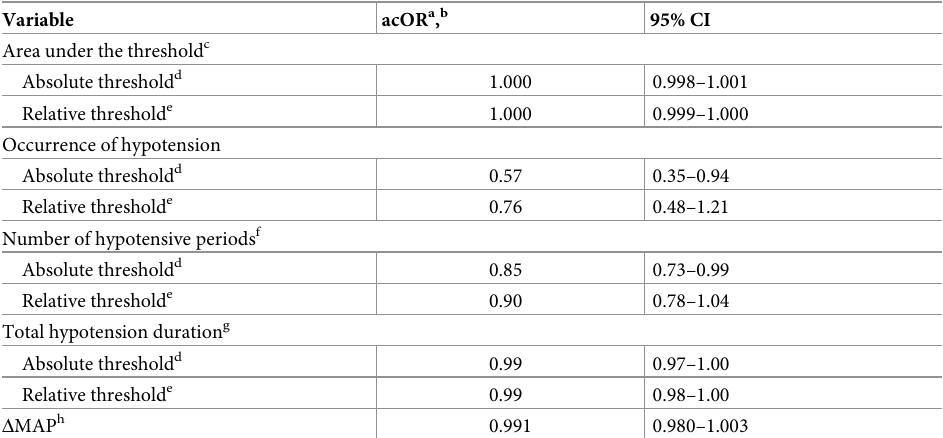
Table 3. Association of procedural hemodynamics with functional outcome.